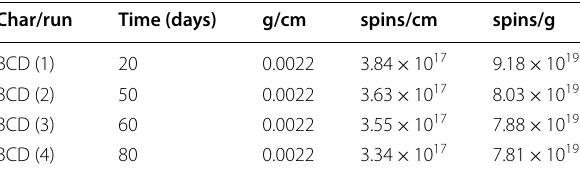
BCD binary mixture of biodiesel and conventional diesel